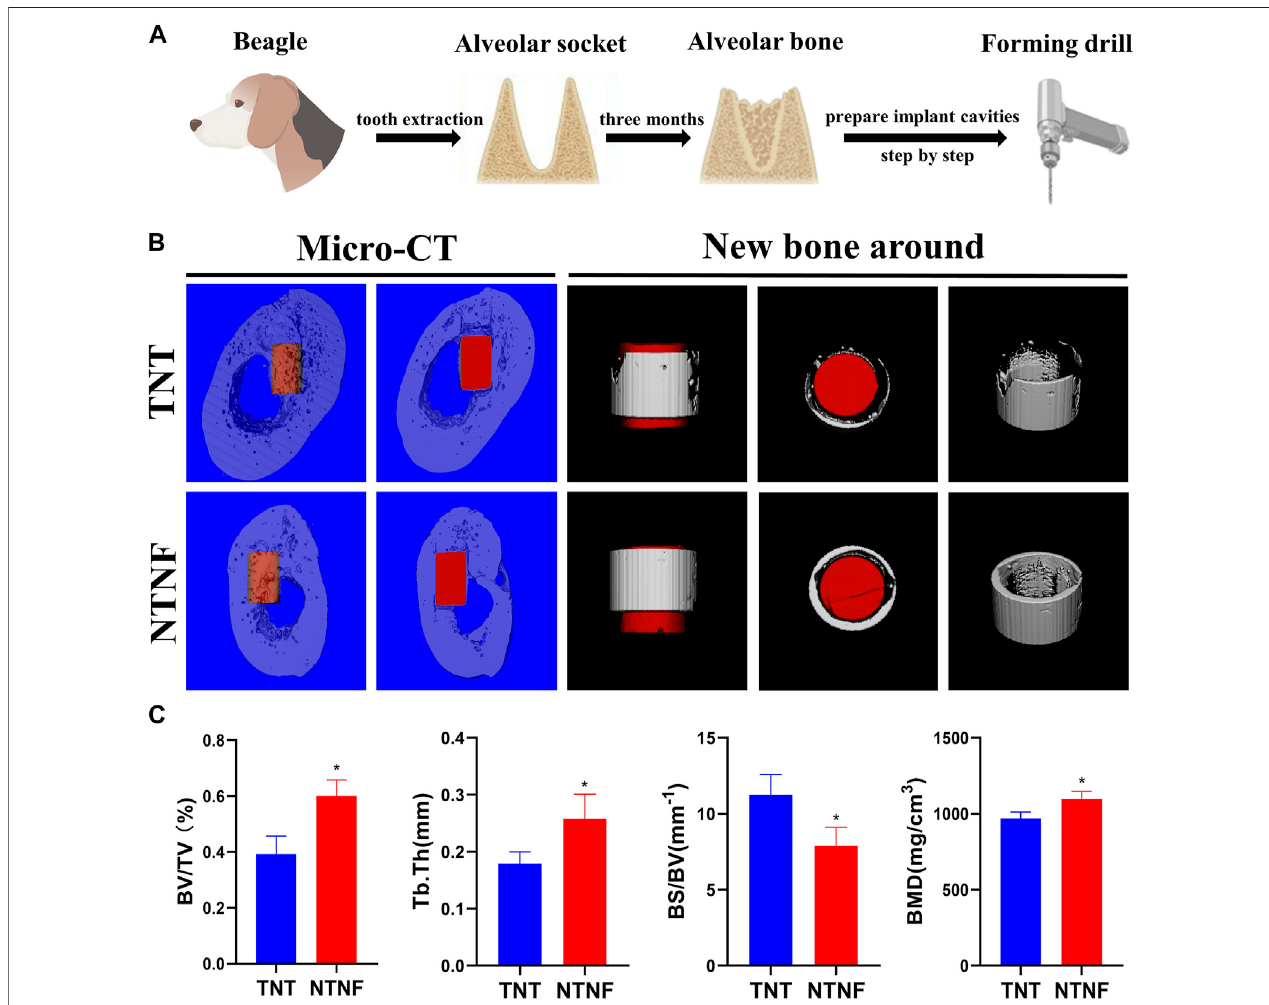
FIGURE 8 | (A) Surgical preparation of titanium rod before implantation. (B) Application of TNT and NTNF implant in beagle jaw, illustrated as micro-CT images including3Dreconstructionandnewbonearoundofthebonerepair3 monthsafterimplantation. (C) BV/TV,Tb.Th,BS/BV,andBMDofthebonevolumeadjacenttothe implant surface were quanti fi ed, respectively ( n = 3,* p <